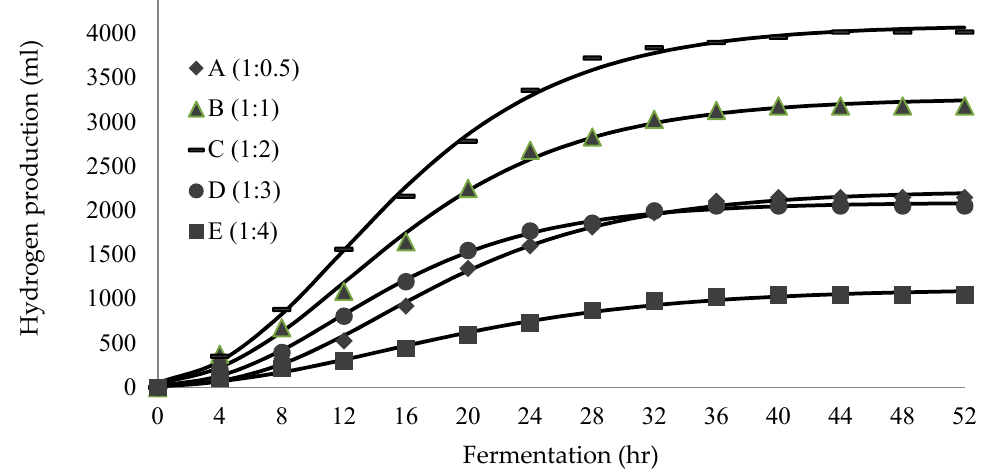
Figure 3. Hydrogen production (mL) at different concentrations of alginate in 200 mL of a 250-mL modified bioreactor in batch fermentation.